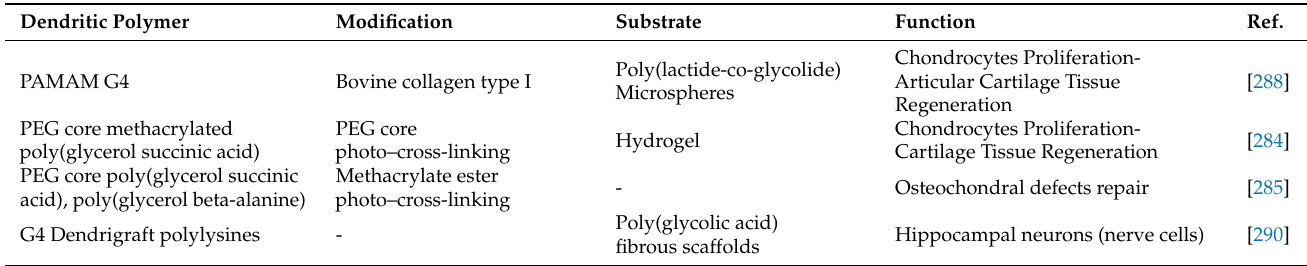
Table 7. Cartilage hepatic aortic neural and pancreatic cell development by the mediation of dendritic